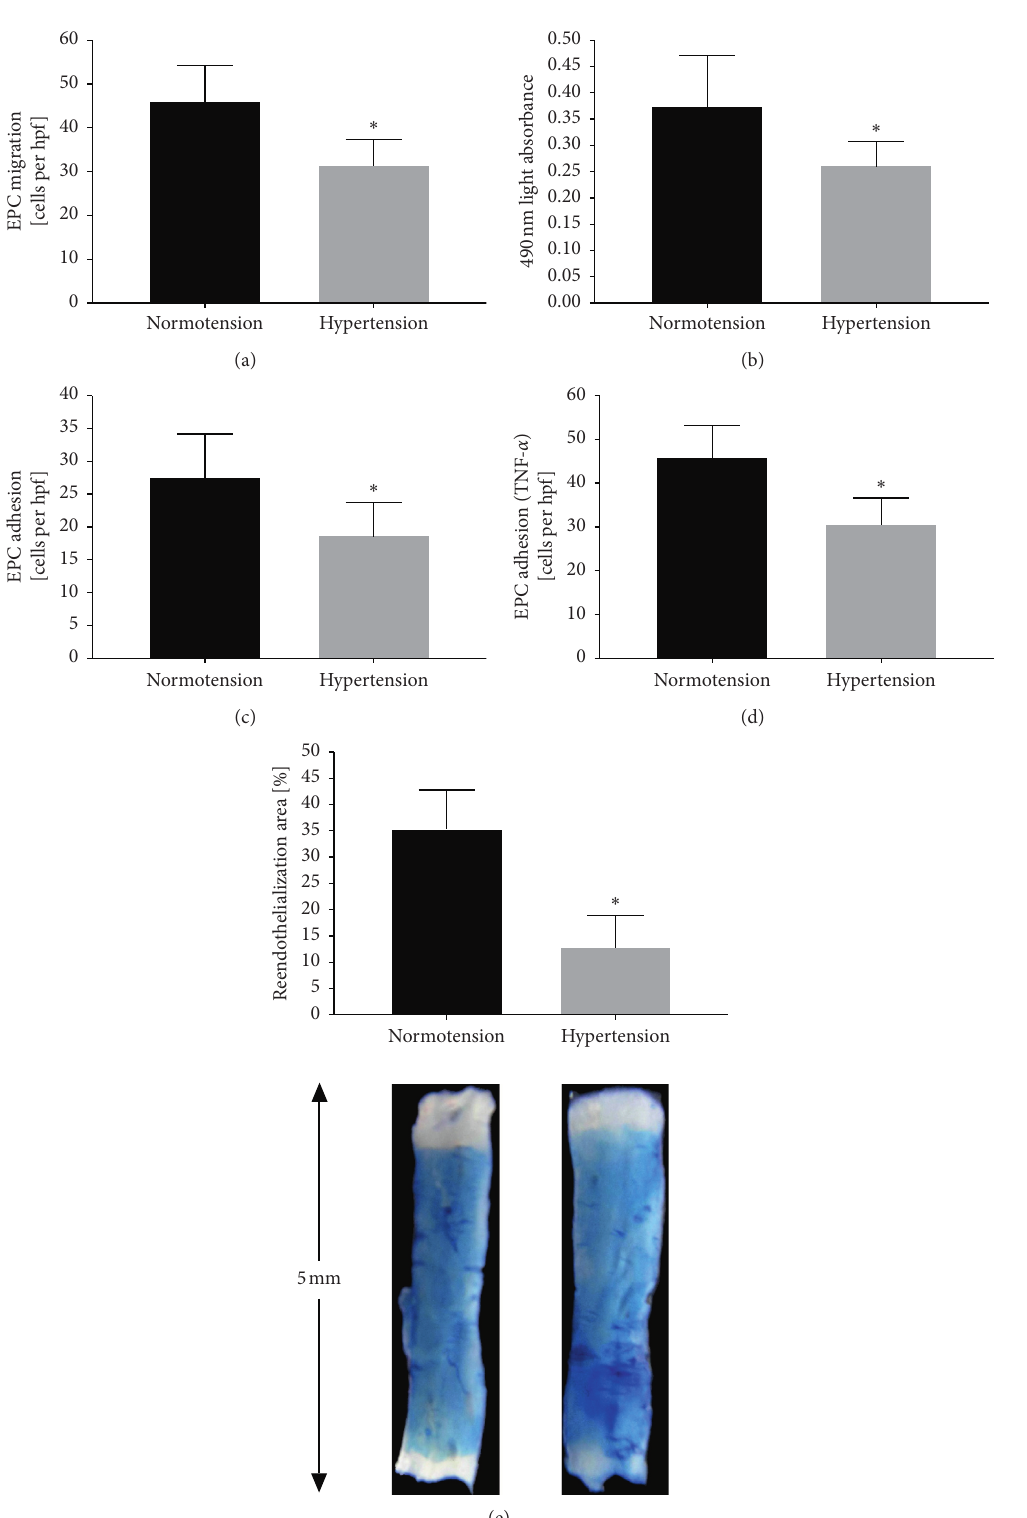
Figure 1: The quantification analysis of the in vitro function and in vivo reendothelialization capacity of human EPCs in the two groups. (a) Quantification analysis of human EPC migration ( ∗ P < 0 . 05 vs. EPCs from normotensive subjects, n � 18 per group). (b) Quantification analysis of the proliferative activity of human EPCs ( ∗ P < 0 . 05 vs. EPCs from normotensive subjects, n � 18 per group). (c)–(d) Quan- tification analysis of human EPC adhesion to HUVECs with or without TNF- α activation ( ∗ P < 0 . 05 vs. EPCs from normotensive subjects, n � 18 per group). (e) Quantification analysis of the area of carotid artery reendothelialization by transplanted EPCs on day 3 after injury ( ∗ P < 0 . 05 vs. EPCs from normotensive subjects, n � 18 per group). hpf � high-power